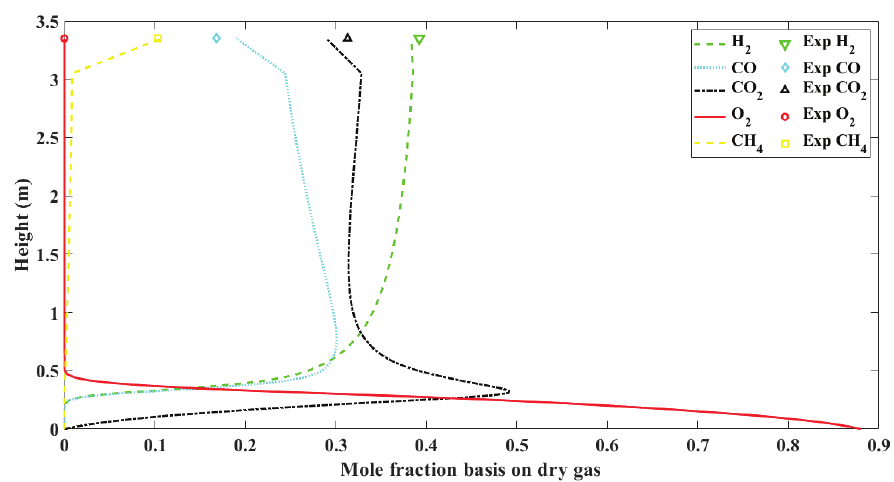
Fig. 2 – Mole fraction of gas components along the reactor on dry gas